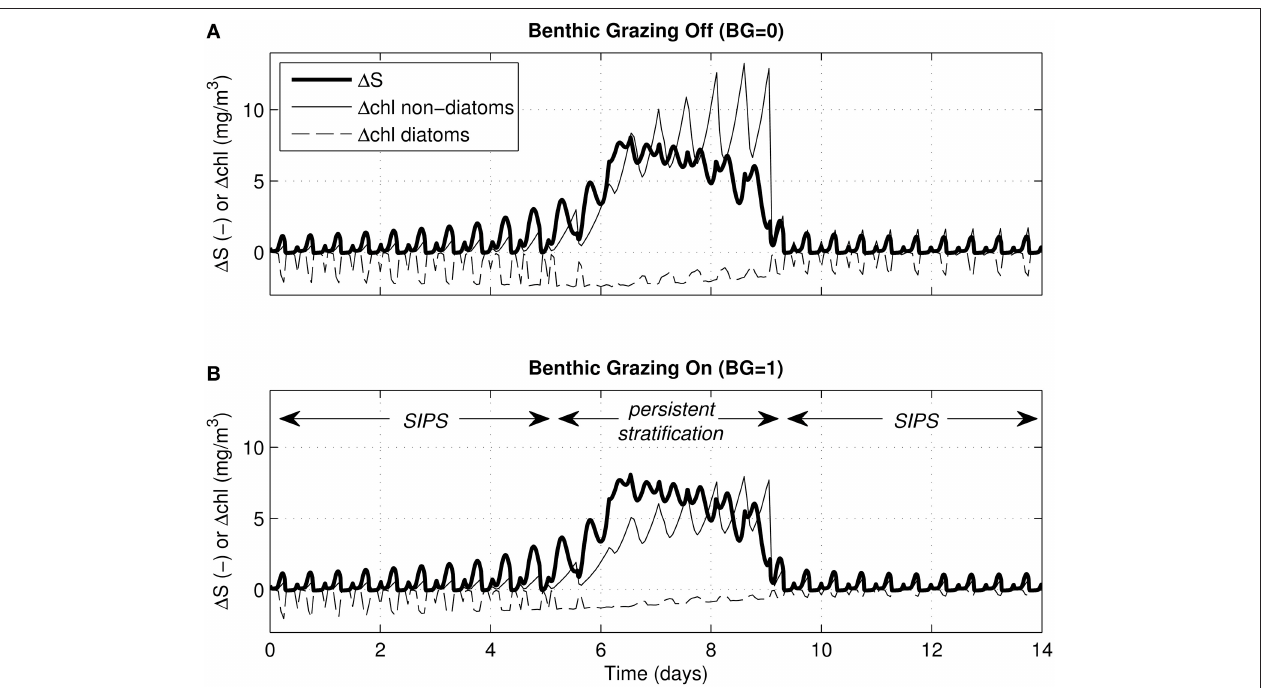
FIGURE 7 | Vertical salinity and chlorophyll differences for generic channel. Time series of 1 S (bottom minus top salinity) and 1 chl (top minus bottom chlorophyll a ) are shown for the same 4 cases depicted in Figures 5C , 6A–D . For all, the water column stratified persistently during neap tide. 1 chl is shown for diatoms (dashed) and non-diatoms (solid). (A) 1 chl curves computed for zero benthic grazing; (B) 1 chl curves computed for benthic grazing rate of 1m 3 /m 2 /d. 1 S (bold solid) is computed by modified BGO turbulence model (same for both panels); 1 chl is based on phytoplankton biomass computed by PS2D